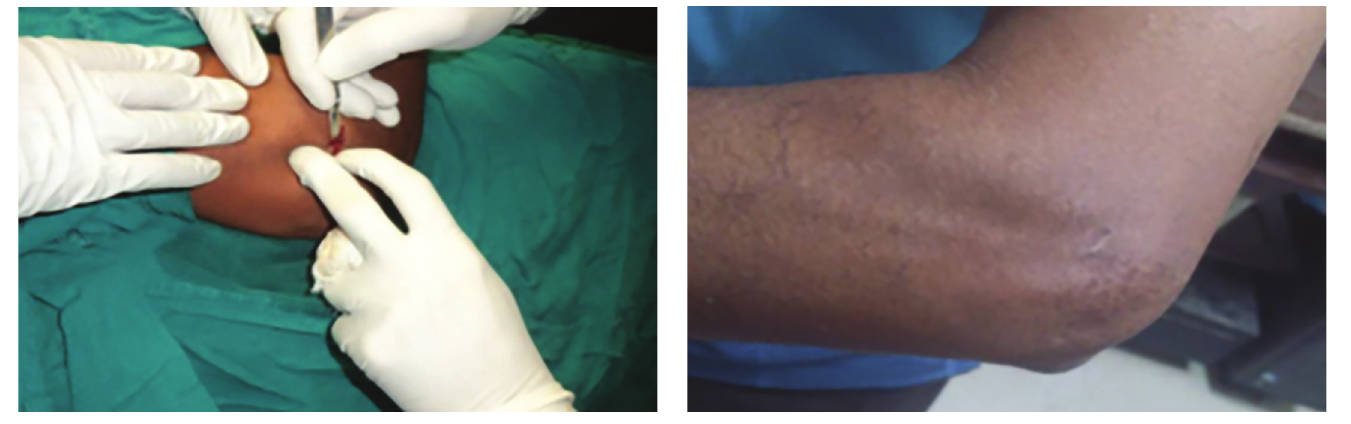
Figure 5 - Post-procedure scar of tenotomy at 8